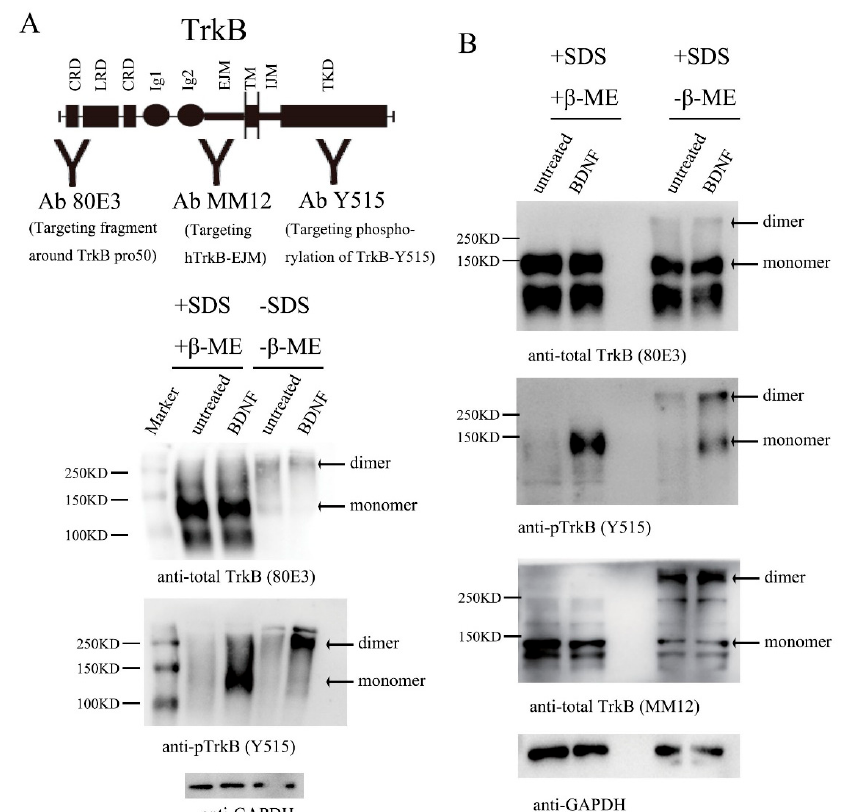
Figure 1. TrkB exists as an inactive and preformed dimer that is activated by brain-derived neurotrophic factor (BDNF) in primarily culture neurons. Rat hippocampus primary culture neurons maintained at 37 ◦ C for 12 days and stimulated with vehicle or BDNF (1.0 nM) for 15 min. The lysates were treated in the presence ( + ) or absence ( − ) of SDS, with ( + ) or without ( − ) β -ME. Equal amounts of lysate proteins (~2 µ g) were loaded in all lanes, and Western blots were performed after gel electrophoresis, using antibodies as indicated. Similar experiments were performed at least three times, and representative blots are presented. ( A ) Top: a diagram of whole TrkB, showing di ff erent domains as well as the sites where di ff erent antibodies bind. CRD: cysteine-rich domains; LRD: leucine-rich domain; Ig1 and Ig2: immunoglobulin-like domain 1 and 2; EJM: extracellular juxtamembrane domain; TM: transmembrane domain; IJM: intracellular juxtamembrane domain; TKD: tyrosine kinase domain. GAPDH: Glyceraldehyde 3-phosphate dehydrogenase. Middle: Existence of TrkB dimer in cultured primary neurons. Note that in native gel without β -ME (the right two lanes), TrkB existed primarily as a dimer. Bottom: activation of TrkB dimer. The same experiment as above was performed, but the blot was probed with an anti-pTrkB antibody, showing activated TrkB. ( B ) Role of disulfide bond in TrkB preformed dimer. All experiments were performed the same way as in A, except lysates were all denatured by SDS, with or without β -ME. Western blots were probed with antibodies 80E3 (top), anti-pTrkB (Y515) (middle), and MM12 (bottom). Note that disruption of disulfide bond by β -ME completely eliminated TrkB